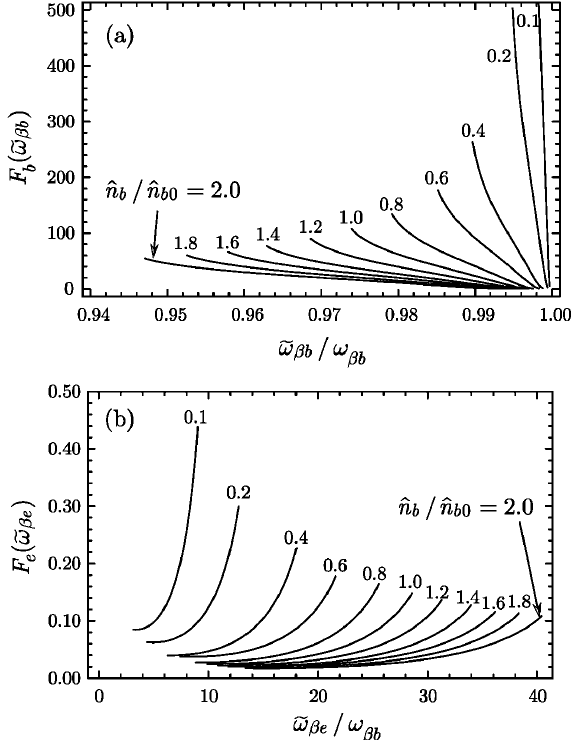
FIG. 6. Plots of the distributions function F (a) protons and (b)